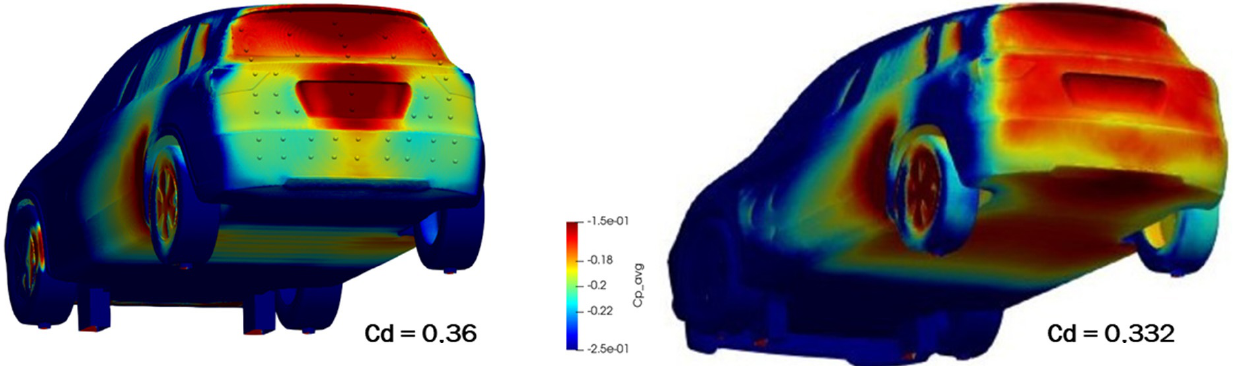
Figure 7. Rear pressure on the last 1000 iterations for the baseline and optimized air dam CFD configuration, respectively, equal to 0.360 and 0.332. Drag coefficient gain is close to 8%. Numerical Cp rear / Cd ratio is equal to 58% when taking pressure taps and close to the ratio of 55% found in measurements. Meanwhile, pressure ratio of the slant and the tailgate surfaces is equal to